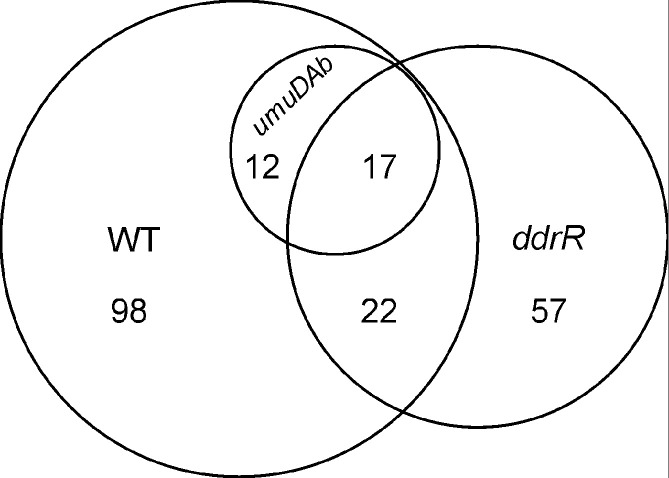
Proportion of the DNA damage-inducible genes that are regulated by ddrR and umuDAb. The relationship between 17978 genes induced after MMC in WT cells and ddrR- and umuDAb-dependent genes induced is shown in an area proportional Venn diagram constructed using the BxToolBox at bioinforx.com.